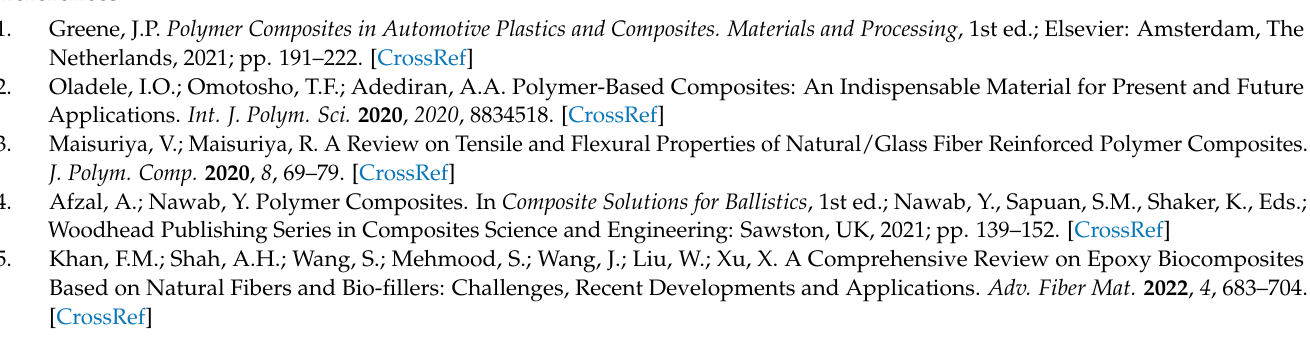
Figure S5: The storage modulus vs. temperature curves for the studied ELALO-based